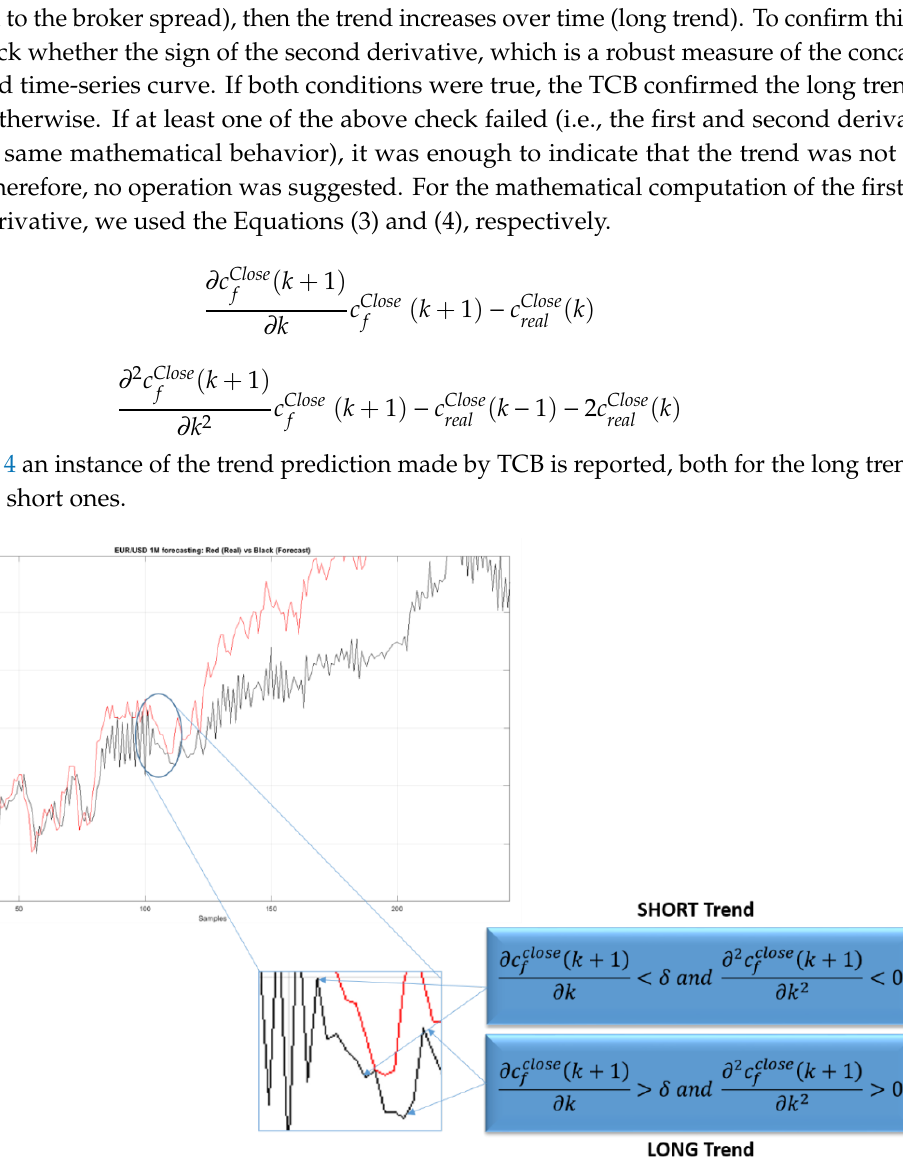
Figure 4. The trend classification block: An instance of trend prediction (EUR/USD, January 2018).